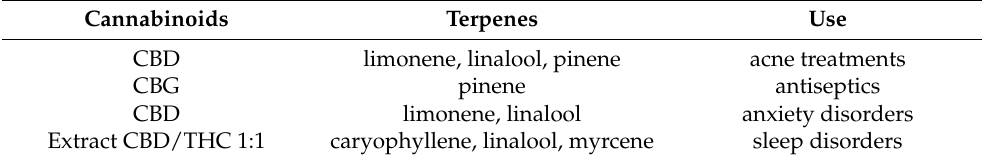
Table 3. Examples of the use of combinations of cannabinoids with terpenes [64]. CBG: cannabigerol.